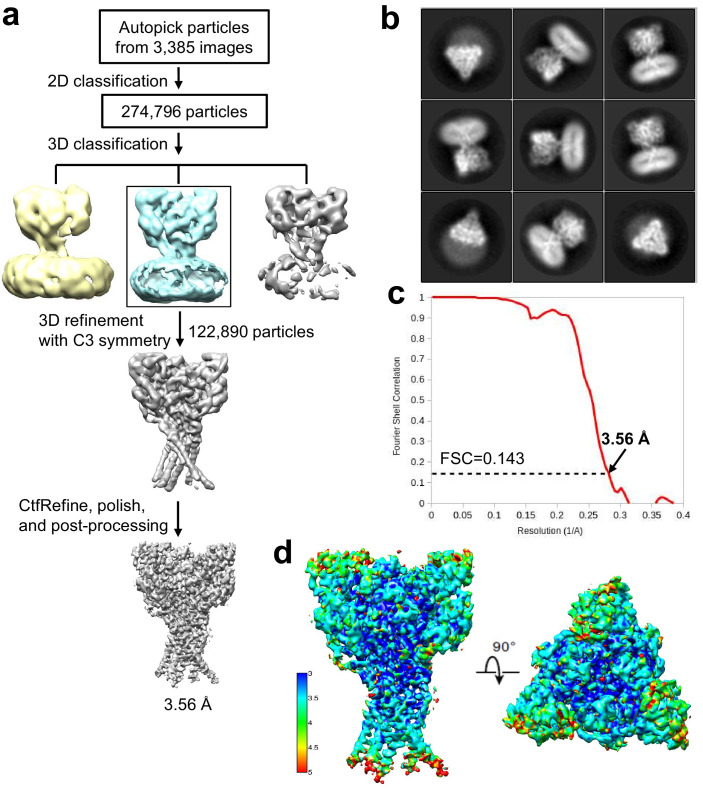
Cryo-EM structure determination of hASIC1aΔC.(a) Flowchart of cryo-EM data processing. (b) Representative 2D class averages of the hASIC1aΔC. (c) The gold-standard Fourier shell correlation curve for the cryo-EM map shown in Figure 2a. (d) Cryo-EM map of the hASIC1aΔC colored by local resolution.